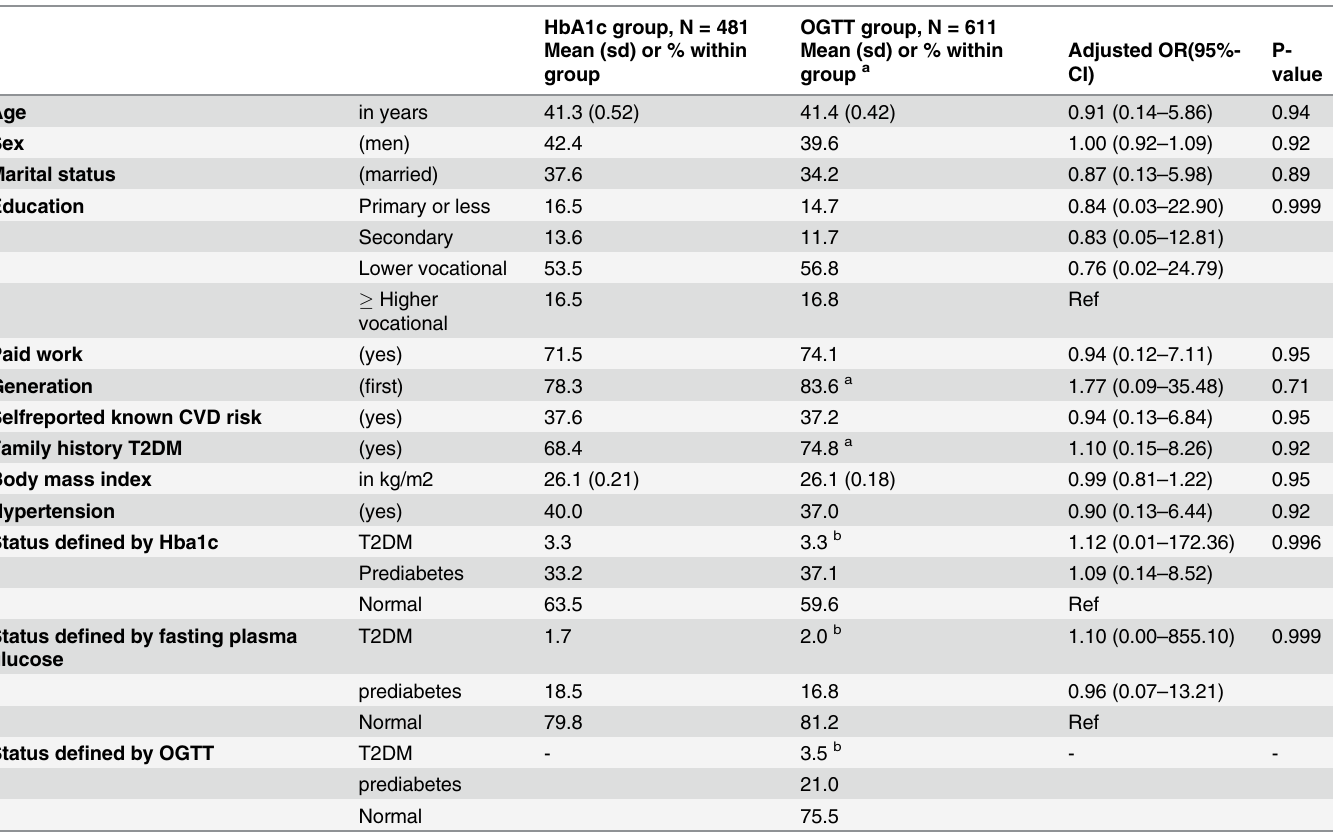
Table 3. Characteristics of participants in the HbA1c group and the OGTT group. OGTT group = people offered screening by means of an OGTT; HbA1c group = people offered screening by means of a glycated hemoglobin measurement; OGTT = oral glucose tolerance test; Adjusted OR = odds ratio for belonging to the OGTT versus HbA1c group, adjusted for age and sex; CI = confidence interval; CVD = cardiovascular disease; T2DM = Type 2 diabetes; Ref = reference group. HbA1c group, N = 481 OGTT group, N = 611 Mean (sd) or %